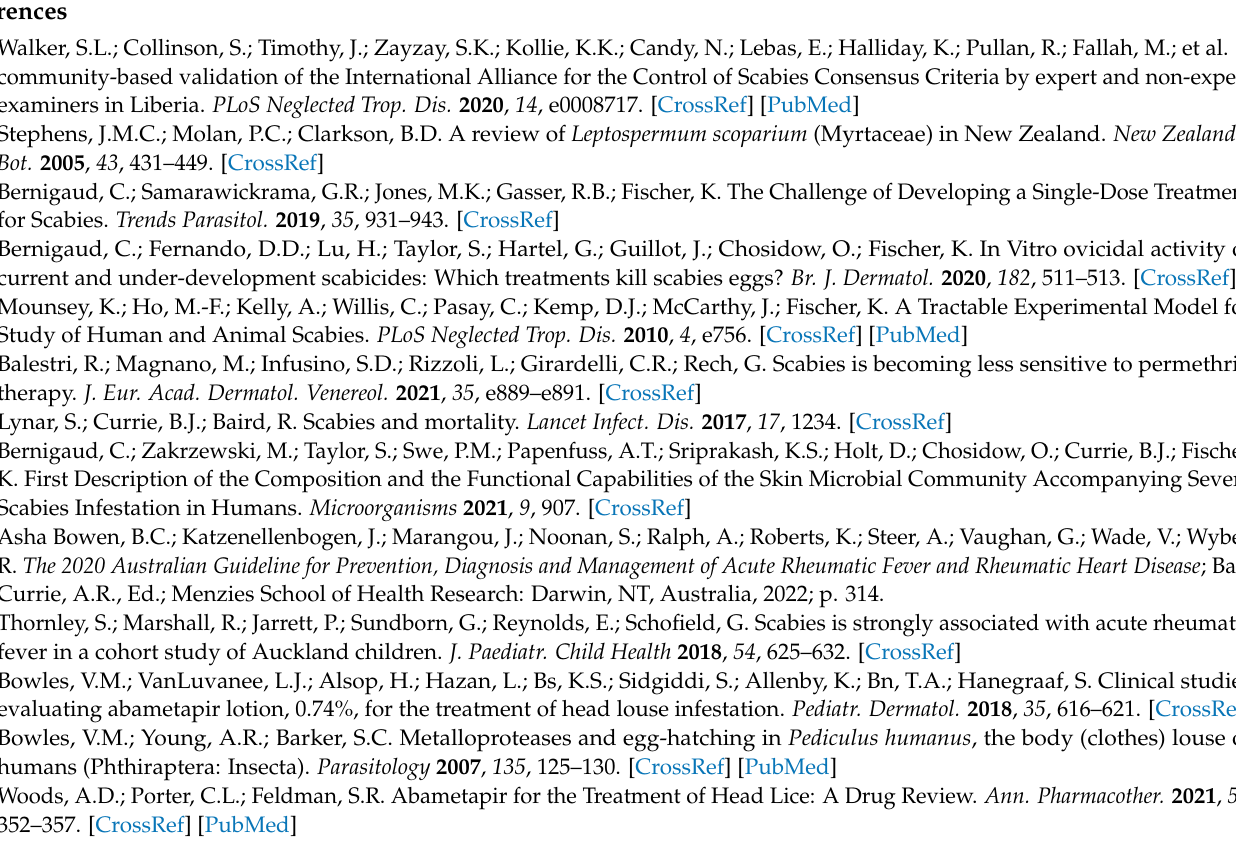
Figure S2: 1 H NMR of Leptospermone; Figure S3: 1 H NMR of Isoleptospermone; Figure S4: 1 H NMR of Grandiflorone; Figure S5: 13 C NMR of Grandiflorone; Table S1: Vehicle controls and antibiotic